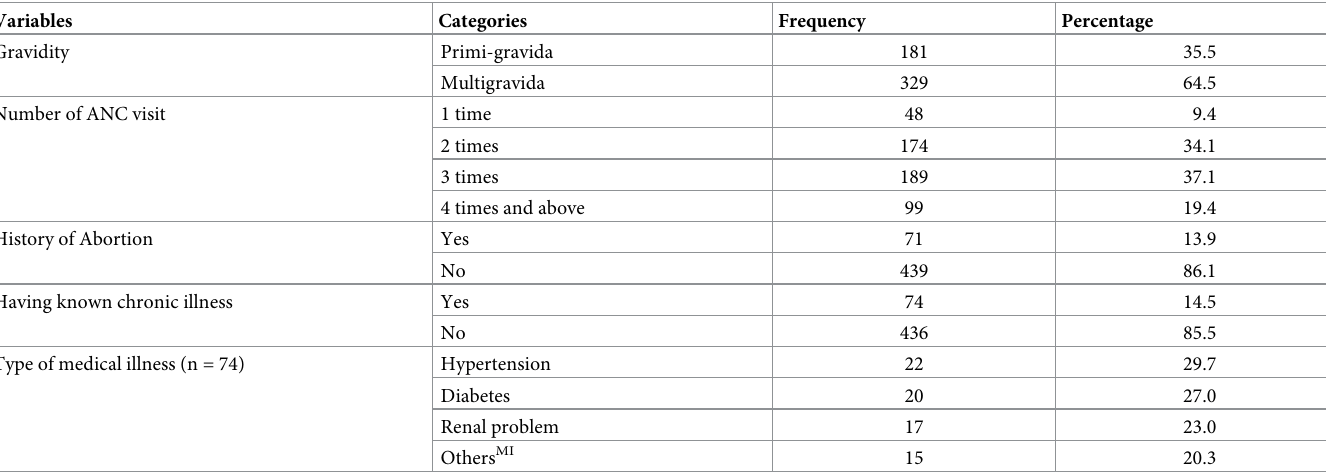
Table 2. Obstetric health care service characteristics of pregnant women attending antenatal care clinic at Gondar town, Northwest Ethiopia, 2021 (n = 510).